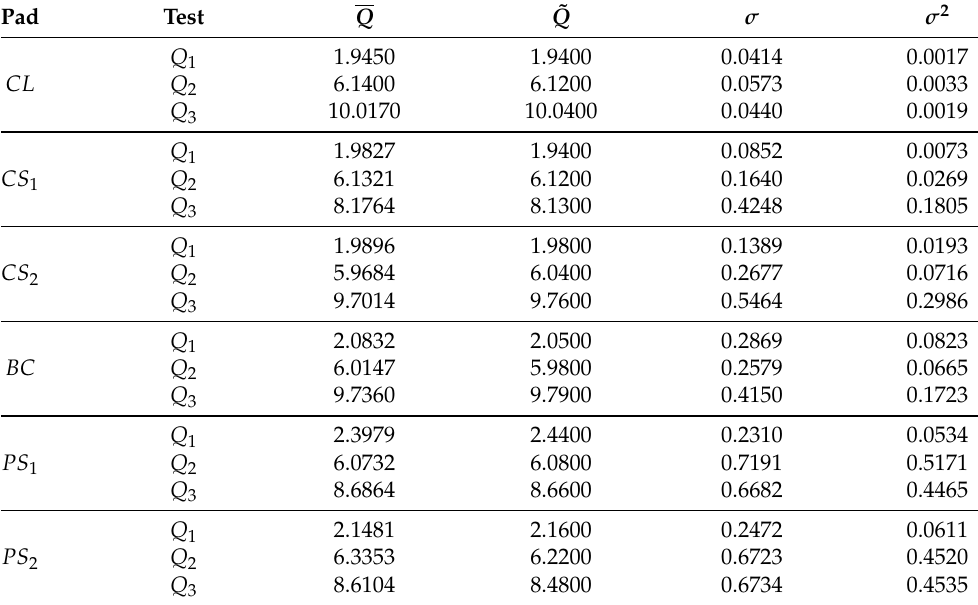
Table 11. Statistics of water flow for all tests in the wind tunnel. Q is the mean [L min − 1 m − 1 ], ˜ Q is the median [L min − 1 m − 1 ], σ is the standard deviation [L min − 1 m − 1 ] and σ 2 is the variance [L 2 min − 2 m − 2